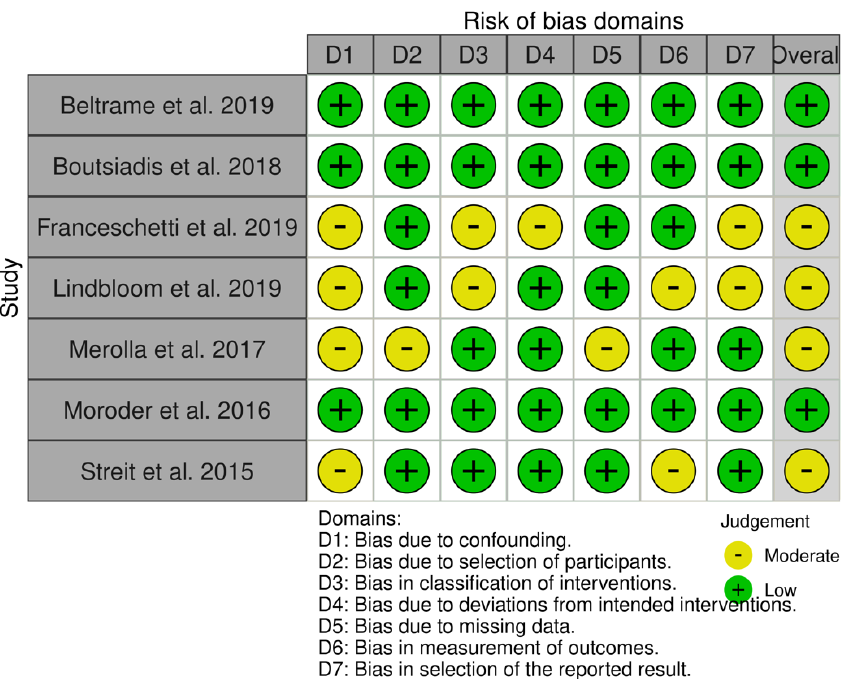
Figure 2. The risk of bias assessments for RCT study [37,38].